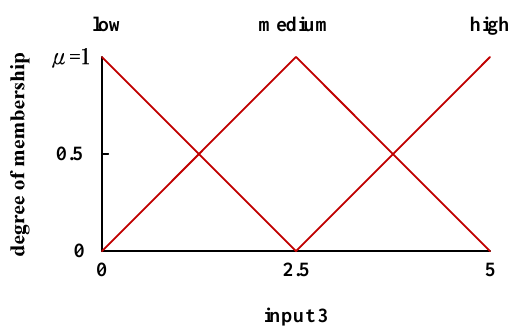
Figure 4. Degree of membership of the feed rate.